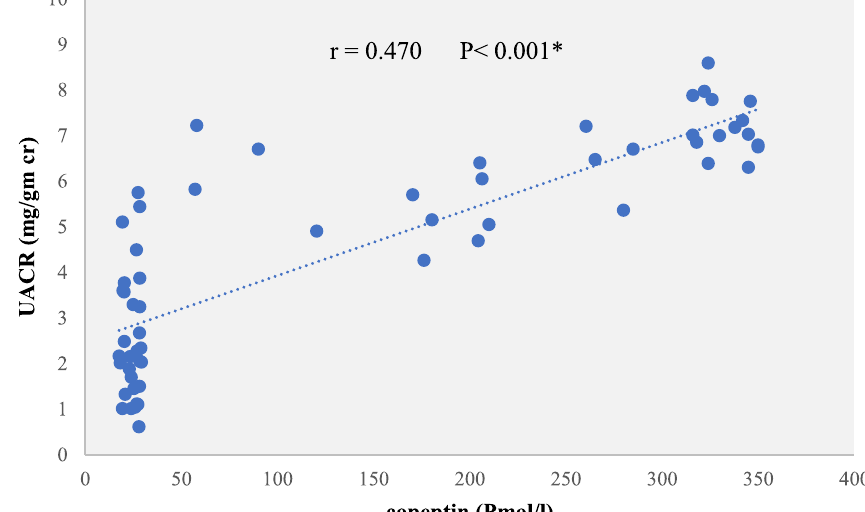
Fig. 3 Correlation between copeptin level and UACR in type 2 diabetic patients ( n 45). Figure shows a statistically significant positive correlation = between copeptin level with urinary albumin creatinine ratio. Abbreviations: U; Urinary, ACR; albumin‑to‑creatinine ratio, r: Pearson’s correlation coefficient, *: Statistically significant ( p ≤